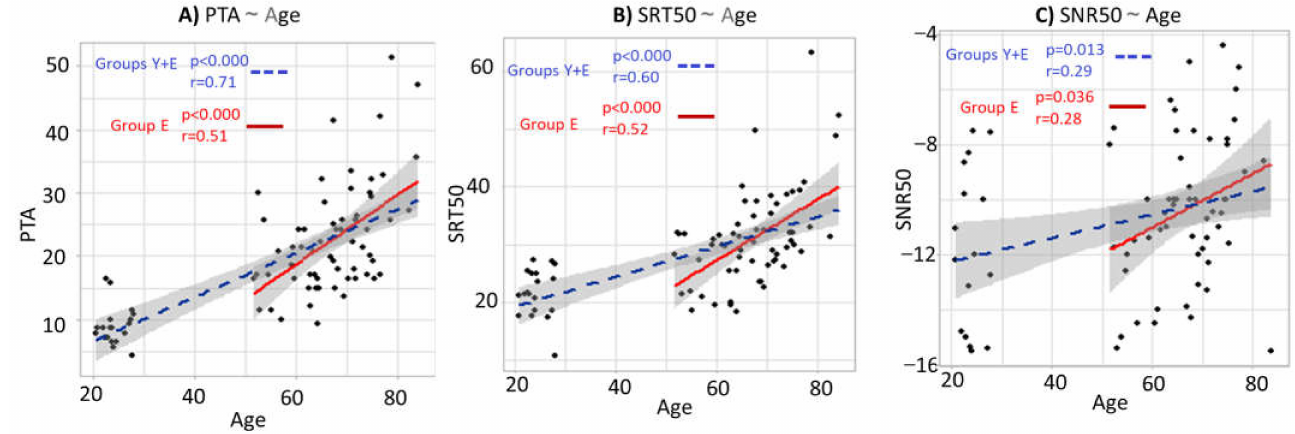
Figure 6. Correlations between hearing and age for the whole population (Group Y + Group E) and Group E only. ( A ) Correlation and regression line between the pure-tone hearing threshold (PTA) and age. ( B ) Correlation and regression line between the speech-in-silence score (SRT50) and age. ( C ) Correlation and regression line between the speech-in-noise score (SNR50) and age. The blue dashed lines represent the regression lines for the whole population (Group Y + Group E). The red lines represent the regression lines for Group E only. The grey areas represent the 95% confidence level interval. The “ r ” represents the Pearson correlation coefficients, and the “ p ” represents the significances of the slopes of the regression